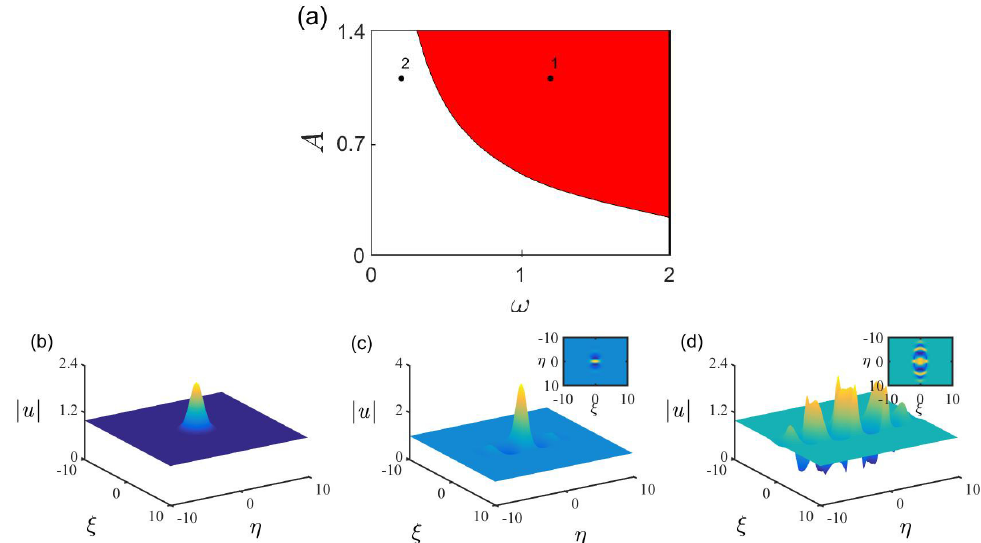
Figure 3. (Color online) ( a ) The existence regions of nonlinear modes as functions of the amplitude ( A ) and width ( ω ) of initial pulse when C = 1. The red region containing point 1 is for high-dimensional rogue waves. ( b – d ) The profiles of nonlinear modes by taking s = 0, 1.08, and 2.0, respectively. Here, ω = 1.2.